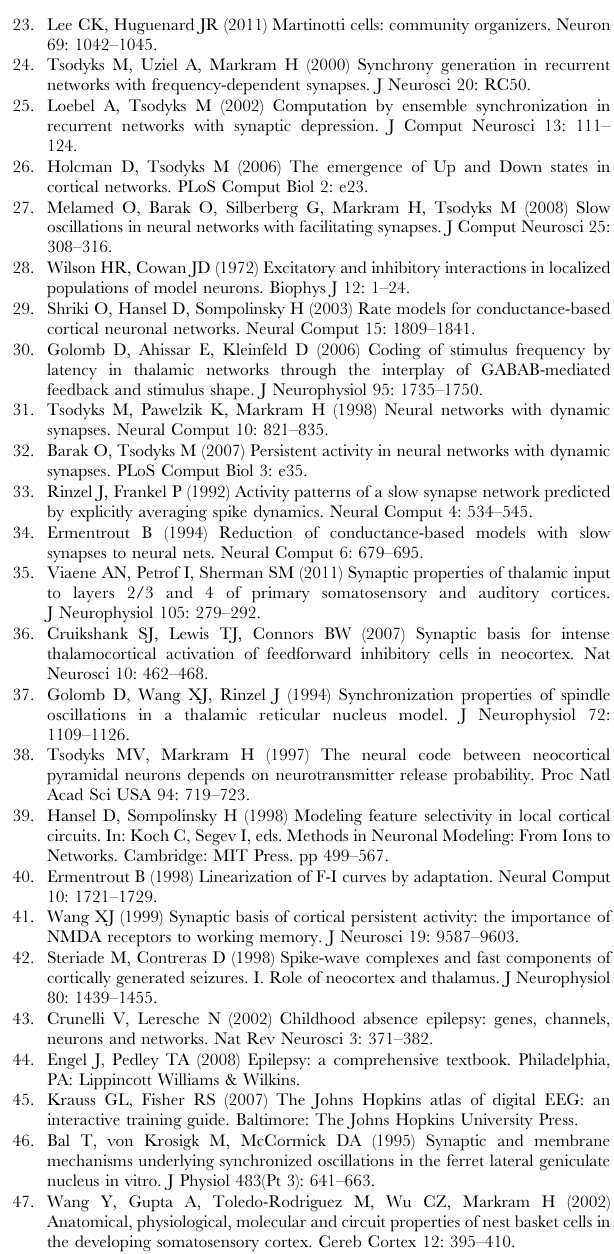
g RR = 40. Graphs on the right side present the same curves during the onset of activity with a shorter time scale. Figure S4 Fast cortical oscillations for large g RR .